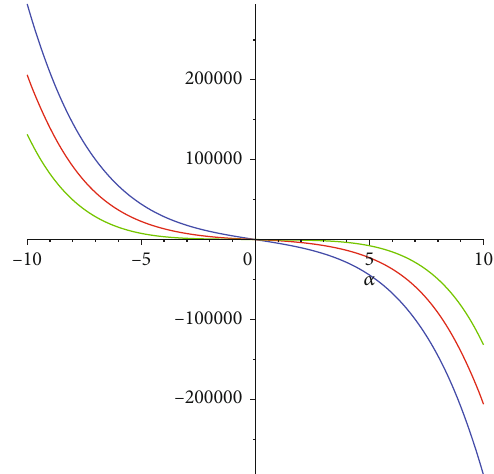
Figure 4: The behavior of stability analysis β ð α Þ and wave number α with the disparate amounts θ = − 5, θ = − 3, θ = − 1